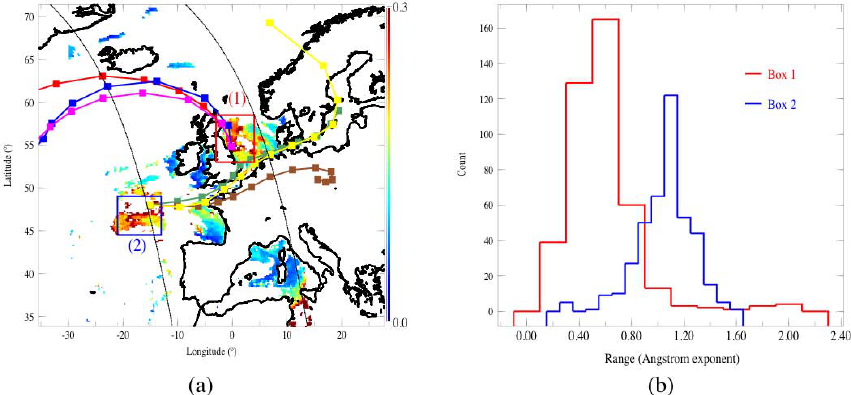
Fig. 1. Aerosol optical thickness (AOT) retrieved at 0.865µm by POLDER over ocean cloud-free pixels. The AOT values are relative to the PARASOL overpasses on 16 April 2010. For the area in panel (a) , box 1, the air mass back trajectories calculated for altitudes equal to 0.5, 1.5, and 3.5km are in red, green, and magenta, respectively. For the area in (a) , box 2, the back trajectories calculated for altitudes equal to 0.5, 1.5, and 3.5km are in green, brown, and yellow, respectively. The coordinates of the ending point of the back trajectories in box 1 are 55 ◦ latitude and − 0.15 ◦ longitude. The coordinates of the ending point of the back trajectories in box 2 are 48 ◦ latitude and − 15 ◦ longitude. The ending points time is 12:00 UTC and the squares denote calculations separated by 6 h. The black thin lines are lidar CALIOP traces. Panel (b) depicts histograms of the Ångström exponent values retrieved for the areas in panel (a) boxes 1 and 2, respectively .